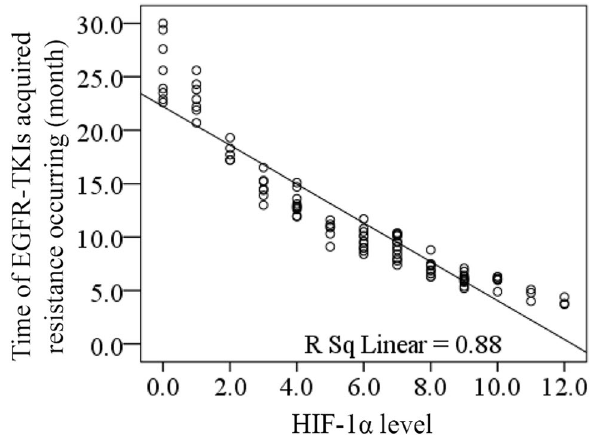
Figure 2. The correlation between the HIF-1α level before receiving treatment and the time of EGFR-TKIs acquired resistance occurring for 103 cases receiving EGFR-TKIs treatment. Linear correlation analysis was adopted to evaluate the correlation between the HIF-1α level before receiving treatment and the time of EGFR- TKIs acquired resistance occurring, and the result showed the negative correlation (R = − 0.938, P = 0.000).